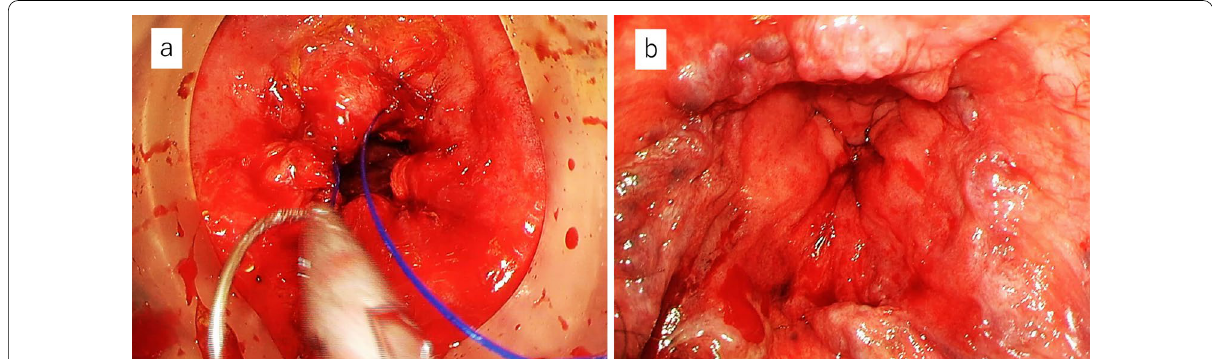
Fig. 2 Distal purse-string suture from below. a After removal of the specimen, the anal edge of the rectum was closed with a purse-string suture by a transanal team. b A photograph taken after completion of the distal purse-string suture